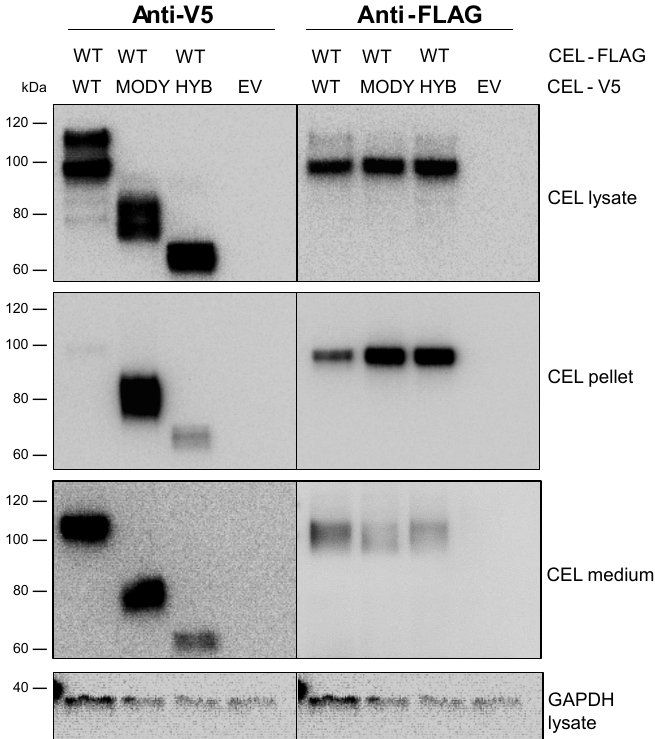
Figure 6. Coexpression and secretion of CEL protein variants in transiently transfected HEK293 cells. The cells were cotransfected with a FLAG-tagged CEL-WT plasmid and plasmids encoding V5-tagged CEL-WT, CEL-HYB, or CEL-MODY. Empty vector (EV) was used as negative control. Soluble (‘lysate’), insoluble (‘pellet’), and medium fractions were collected 48 h after cotransfection and analyzed by western blotting using anti-FLAG and anti-V5 tag-specific antibodies. GAPDH in the lysate fraction was used as loading control. The image shown is representative of three independent